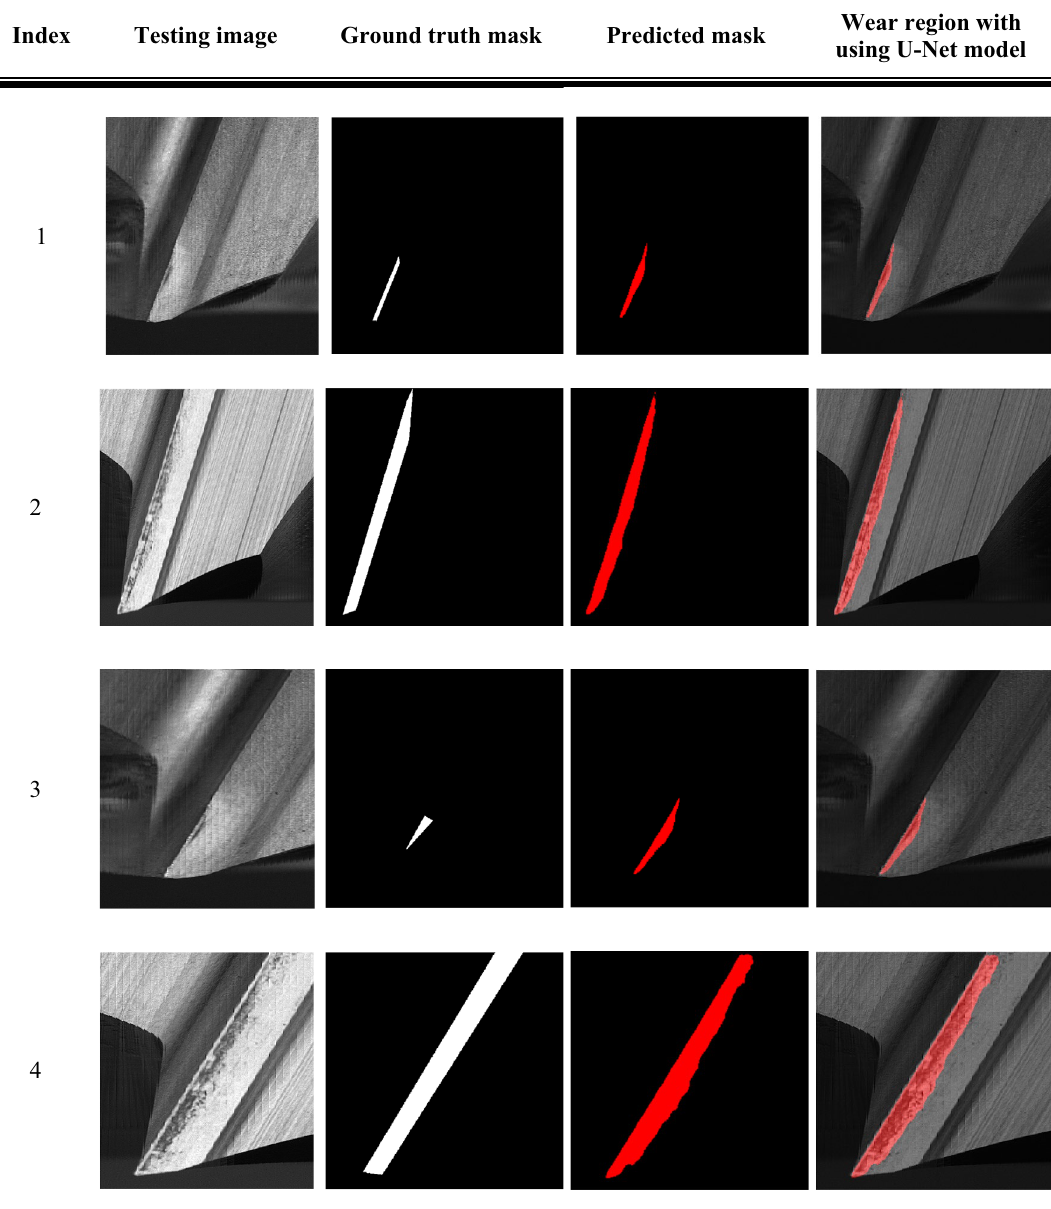
Table 6. The detection results by using U-Net